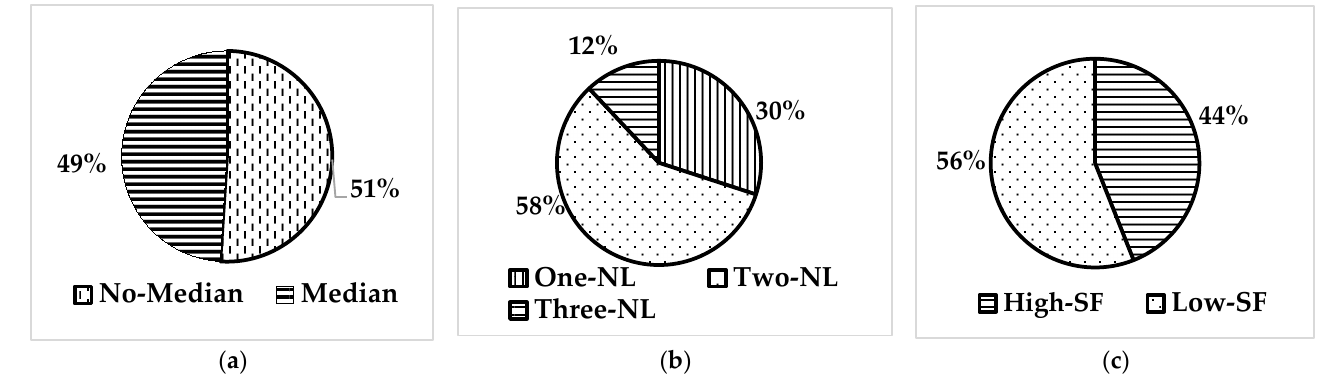
Figure 4. Percentage quantity of cross-section parameter values over the surveyed urban roads. ( a ) Median Existence. ( b ) Number of Lanes. ( c ) Side Frictions.